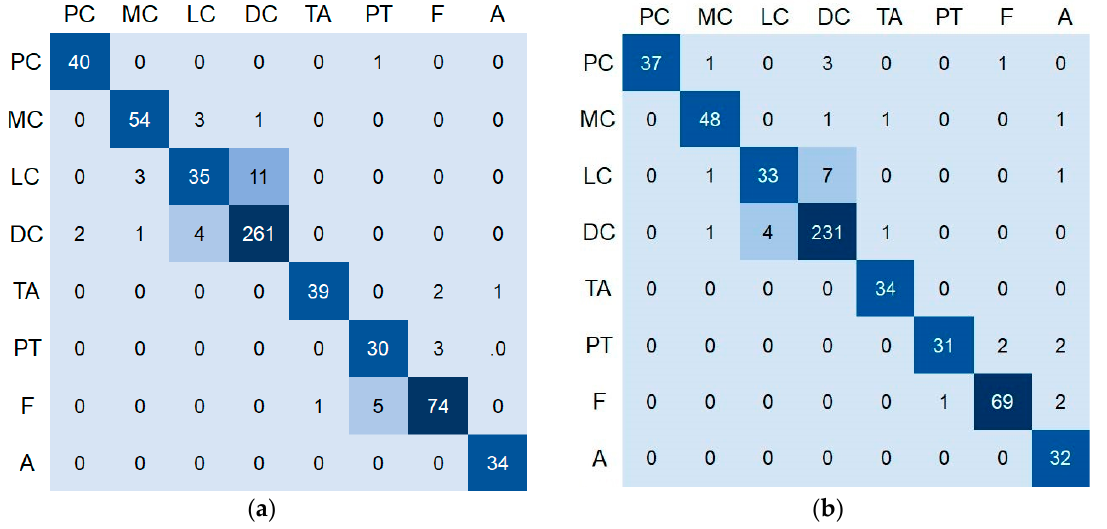
Figure 9. The multi-class confusion matrix of the proposed model for ( a ) 200 × test set and ( b ) 400 × test set.